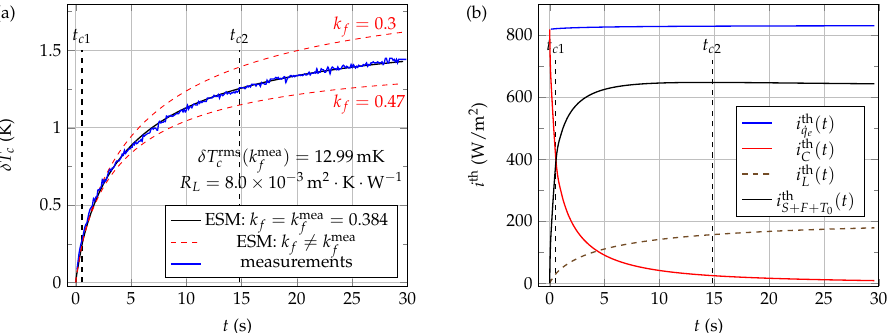
Figure 20. Experimental and 1D ESM computed thermal signals in the case of water–glycerol mixture 40W60G at rest. These signals were obtained using a voltage step excitation v 0 = 8.39V at a working temperature T 0 = 24.0 ◦ C and immersion length L i = 0.0mm: ( a ) measurements and ESM results; ( b ) computed thermal current densities when the fluid thermal conductivity k f is set to the value = 0.384 in the ESM model. Thermal conductivities k · K − 1 · m − 1 k mea f are given in W f